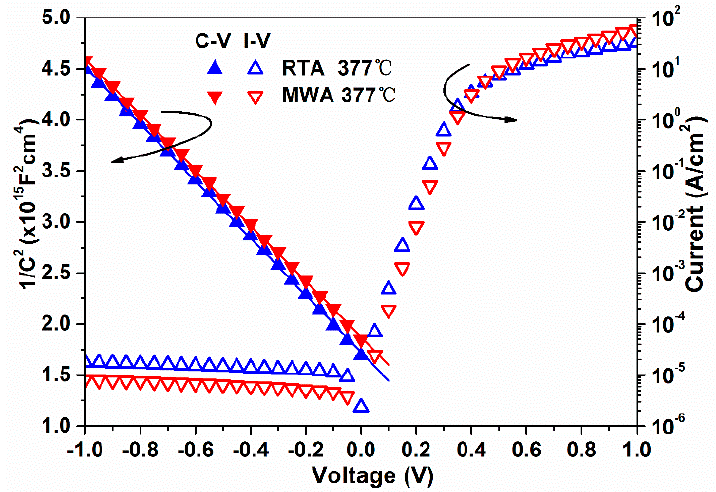
Figure 4. Capacitance-voltage (C-V) and current-voltage (I-V) characteristics of diodes annealed with 600 s on the n-type substrate.